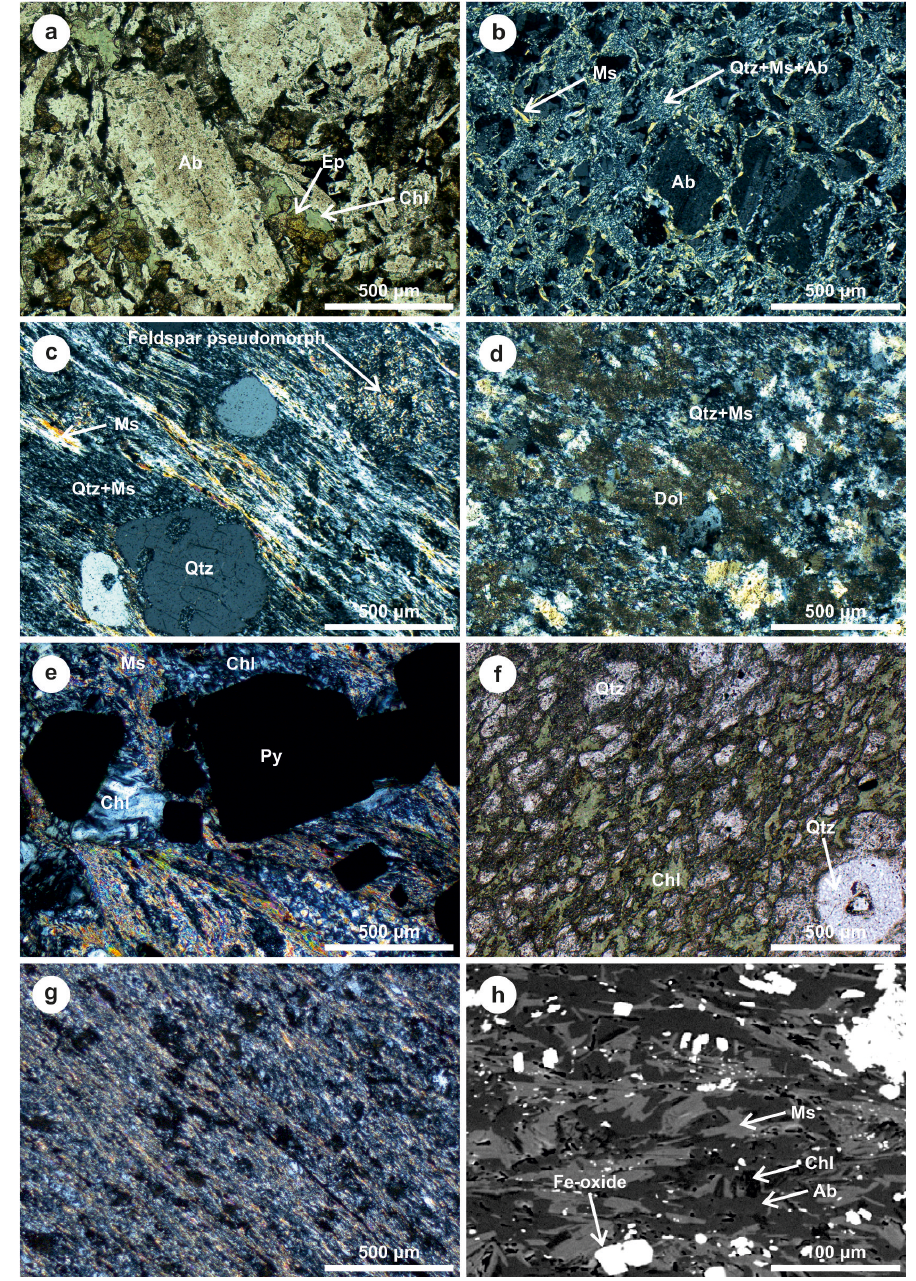
Figure 7. Photomicrographs of altered rocks in the host sequence of the Aguas Teñidas deposit. (a) Distal volcanic rock of intermediate composition (sample MU-2/895.5, collected at a depth of 895.5m along core MU-2) affected by seafloor alteration; plane-polarized light. (b) Distal URD (sample MU-5/875.25) affected by seafloor alteration; cross-polarized light. (c) Hydrothermally altered URD in the sericite alteration zone (sample AE-68/367.6); cross-polarized light. (d) URD in the distal stockwork zone (sample AE-69/384.0), with quartz– sericite and carbonate alteration; cross-polarized light. (e) URD in the medial part of the central stockwork (sample DST-332/139.7), with quartz + sericite + chlorite alteration; cross-polarized light. (f) URD in the central part of the central stockwork (sample DST-332/251.5), with chlorite + quartz alteration – note the preserved quartz phenocrysts; plane-polarized light. (g) Fine-grained mafic volcaniclastic rock in the hanging wall oxidized albitic alteration zone (sample AGI-888/238.7); it consists of a fine-grained muscovite + albite + minor chlo- rite + iron oxides assemblage; cross-polarized light. (h) Detail of the fine-grained mineral assemblage in sample AGI-888/238.7; backscat- tered electron scanning electron microscope image. Ab: albite; Chl: chlorite; Dol: dolomite; Ep: epidote; Ms: muscovite; Py: pyrite; Qtz: